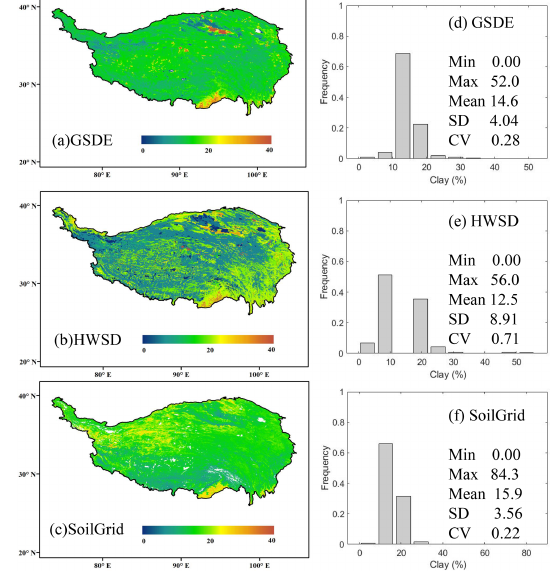
Figure 6. Spatial distribution of soil bulk density on the TP derived from (a) GSDE, (b) HWSD, and (c) SoilGrid. Corresponding his- tograms are also shown in (d) – f) .